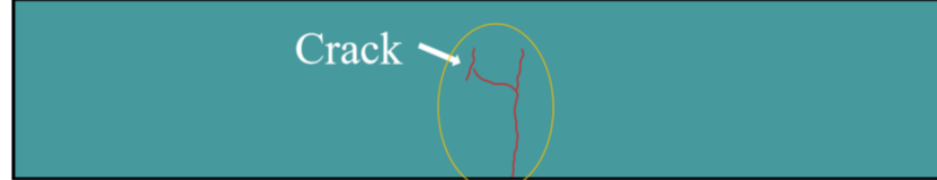
Figure 5. Fatigue failure morphology of SSUHPC: Schematic diagram of fatigue failure.